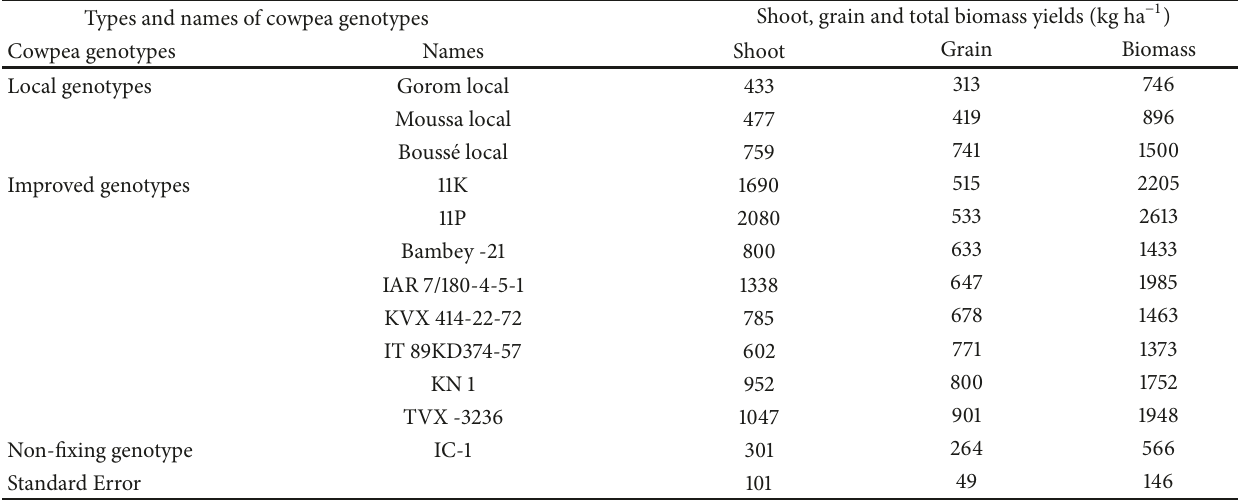
Table 2: Grain, shoot, and total biomass yields of local and improved genotypes and nonfixing cowpea. Types and names of cowpea